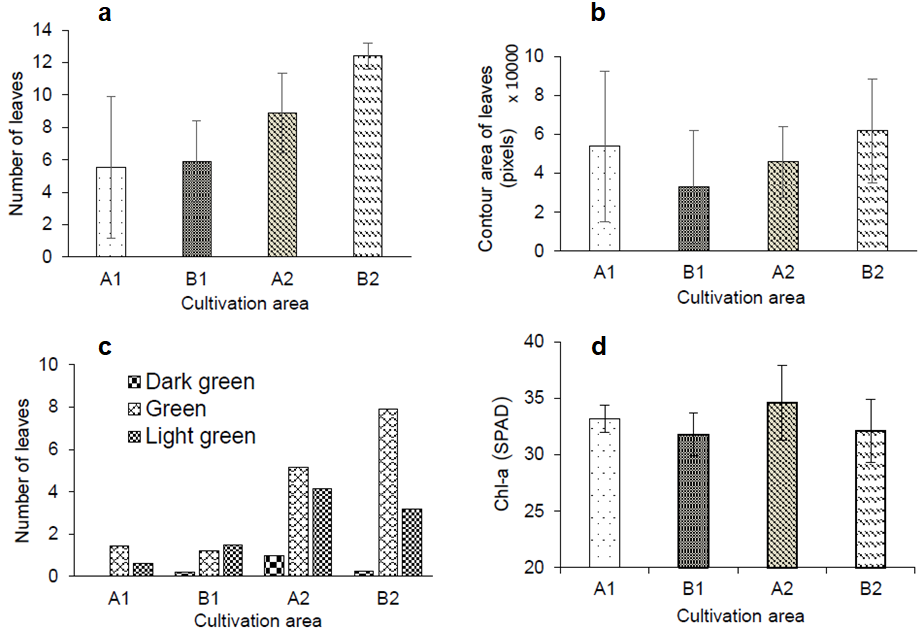
Figure 14. Light treatment results for the first stage of the experiment: ( a ) number of leaves, ( b ) contour area of leaves, ( c ) colour of leaves, and ( d ) relative chlorophyll-a.